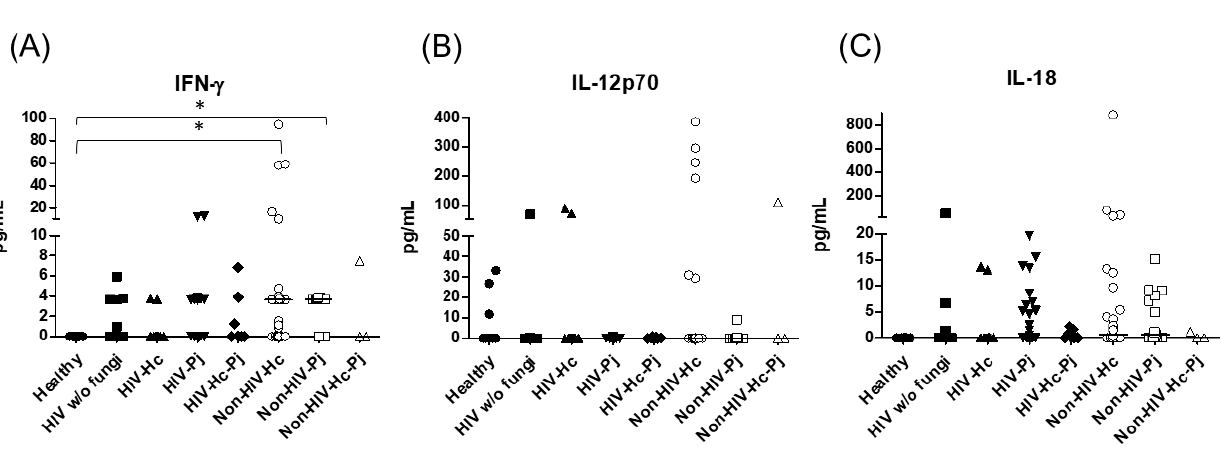
IL-18 did not show any differences. It is noteworthy that the non-HIV patient groups had